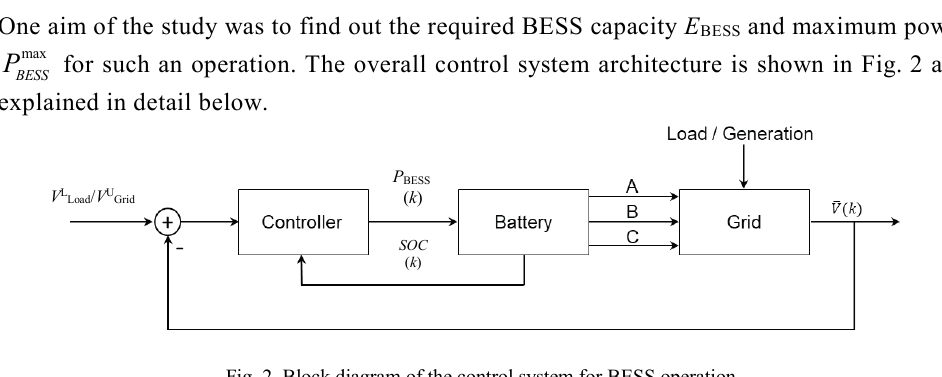
Fig. 2. Block diagram of the control system for BESS